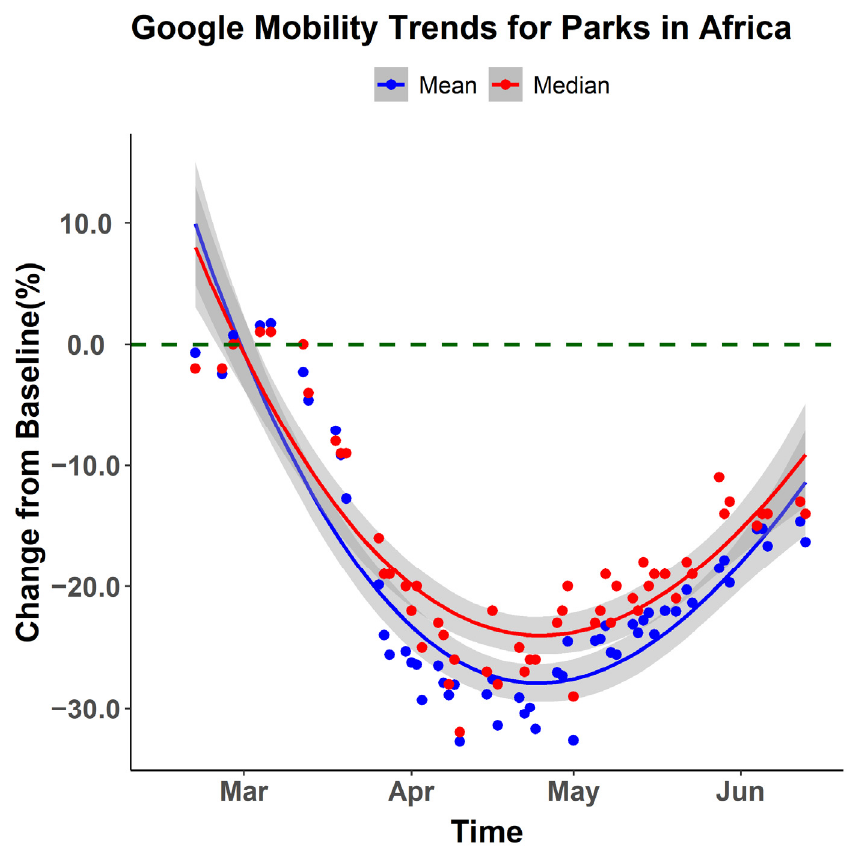
Figure 1. Google mobility trends for parks in Africa. As per the Google mobility data, parks typi- cally refer to official national parks and not the general outdoors found in rural areas.